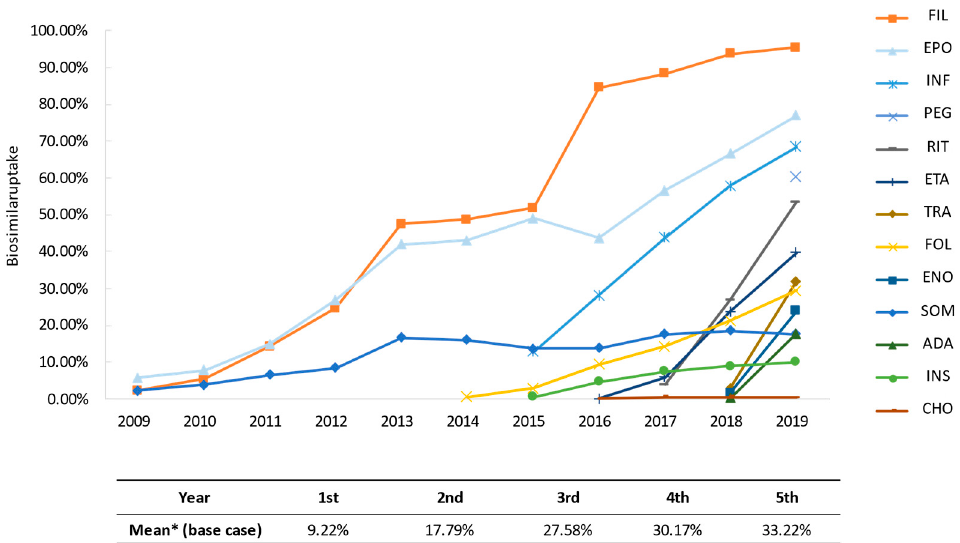
Figure 6. Biosimilar penetration in Spain over time (adapted from [29]). Biosimilar uptake (%) is calculated as volume of biosimilars over volume of biosimilars plus the originator product (DDDs). * Chondroitin sulfate and the three